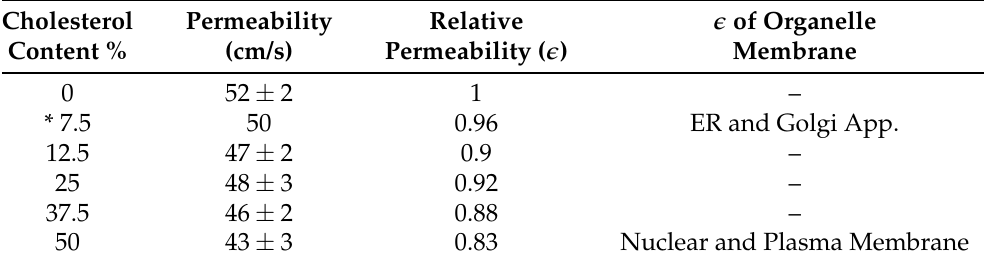
Table 1. Oxygen membrane permeability values at varying cholesterol levels from [5]. Relative permeability ( (cid:101) ) used for different organelles of the cell, which is defined as the ratio between the permeability values of a membrane containing cholesterol and one without cholesterol. * Interpolated value for ER membrane